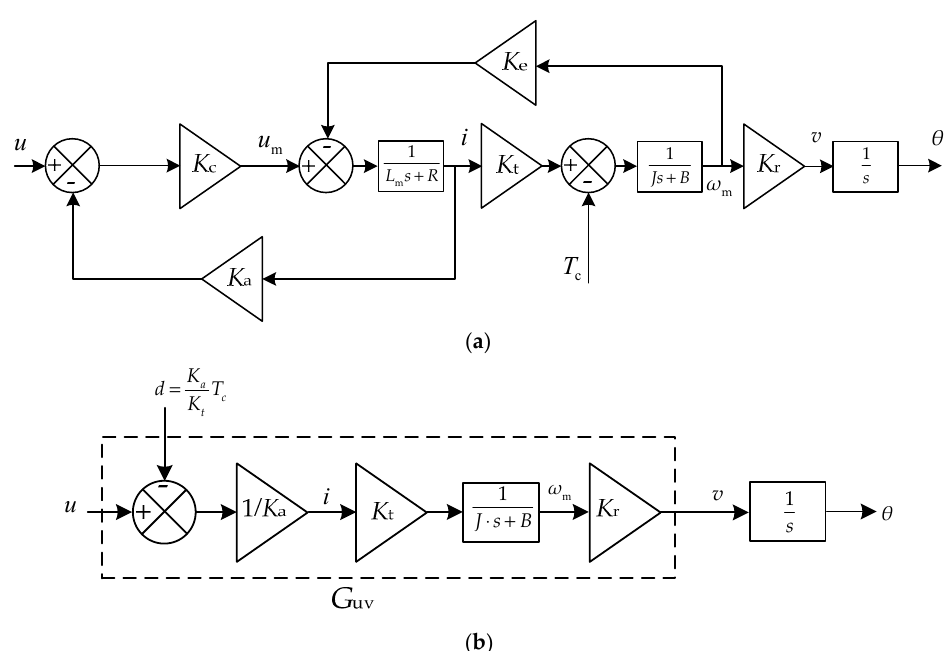
Figure 2. Transfer function block diagram of ( a ) the complete speed open-loop system, and ( b ) the simplified speed open-loop system.